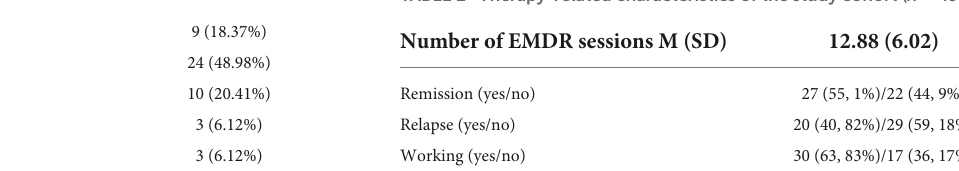
TABLE 2 Therapy-related characteristics of the study cohort ( n =